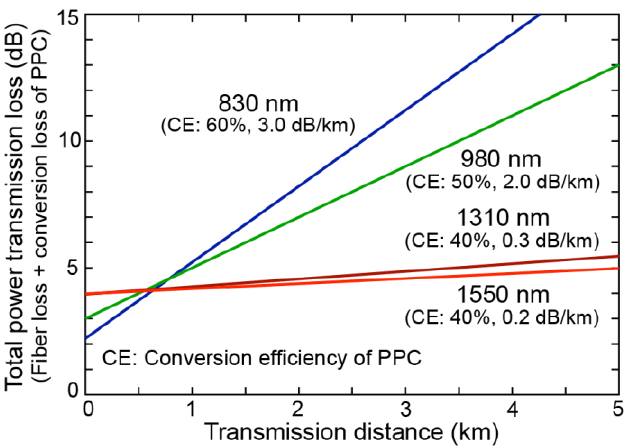
Figure 3. Example of transmission distance versus transmission and conversion losses for various feed light wavelengths.